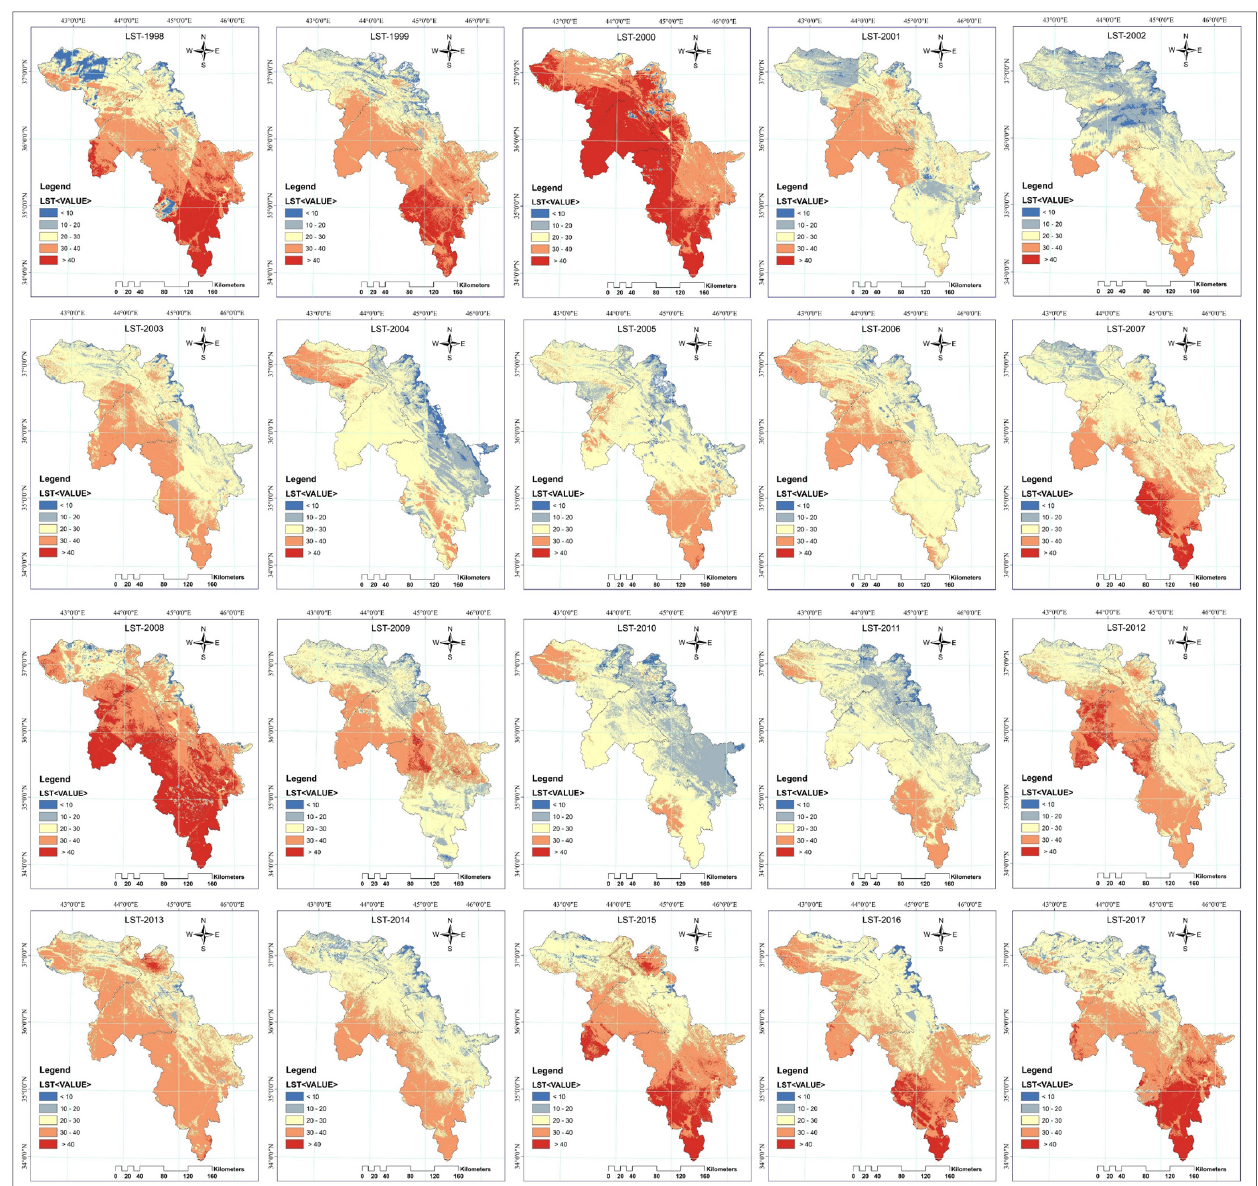
Figure 7. Drought Severity Categories based on LST Index in Years